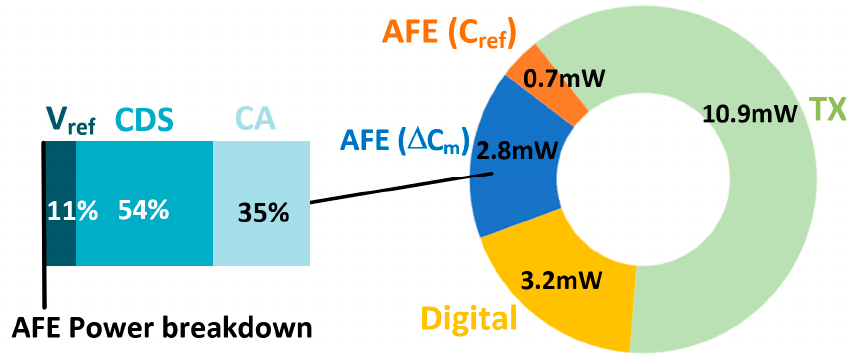
Figure 23. Power breakdown of designed AFE. Table 1. Performance summary and Comparison to Previous